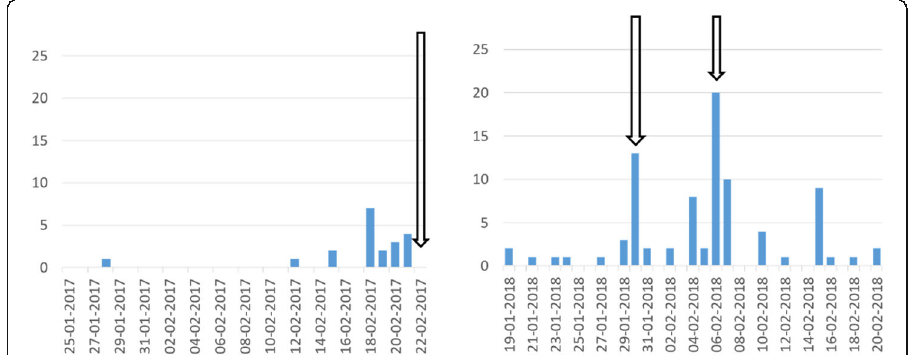
Fig. 10 Temporal distribution of posted messages in Topic 6. In the left side, the academic year of 2016/ 2017 and in the right side, the academic year of 2017/2018. The arrows show the deadlines for delivery of work and / or activities